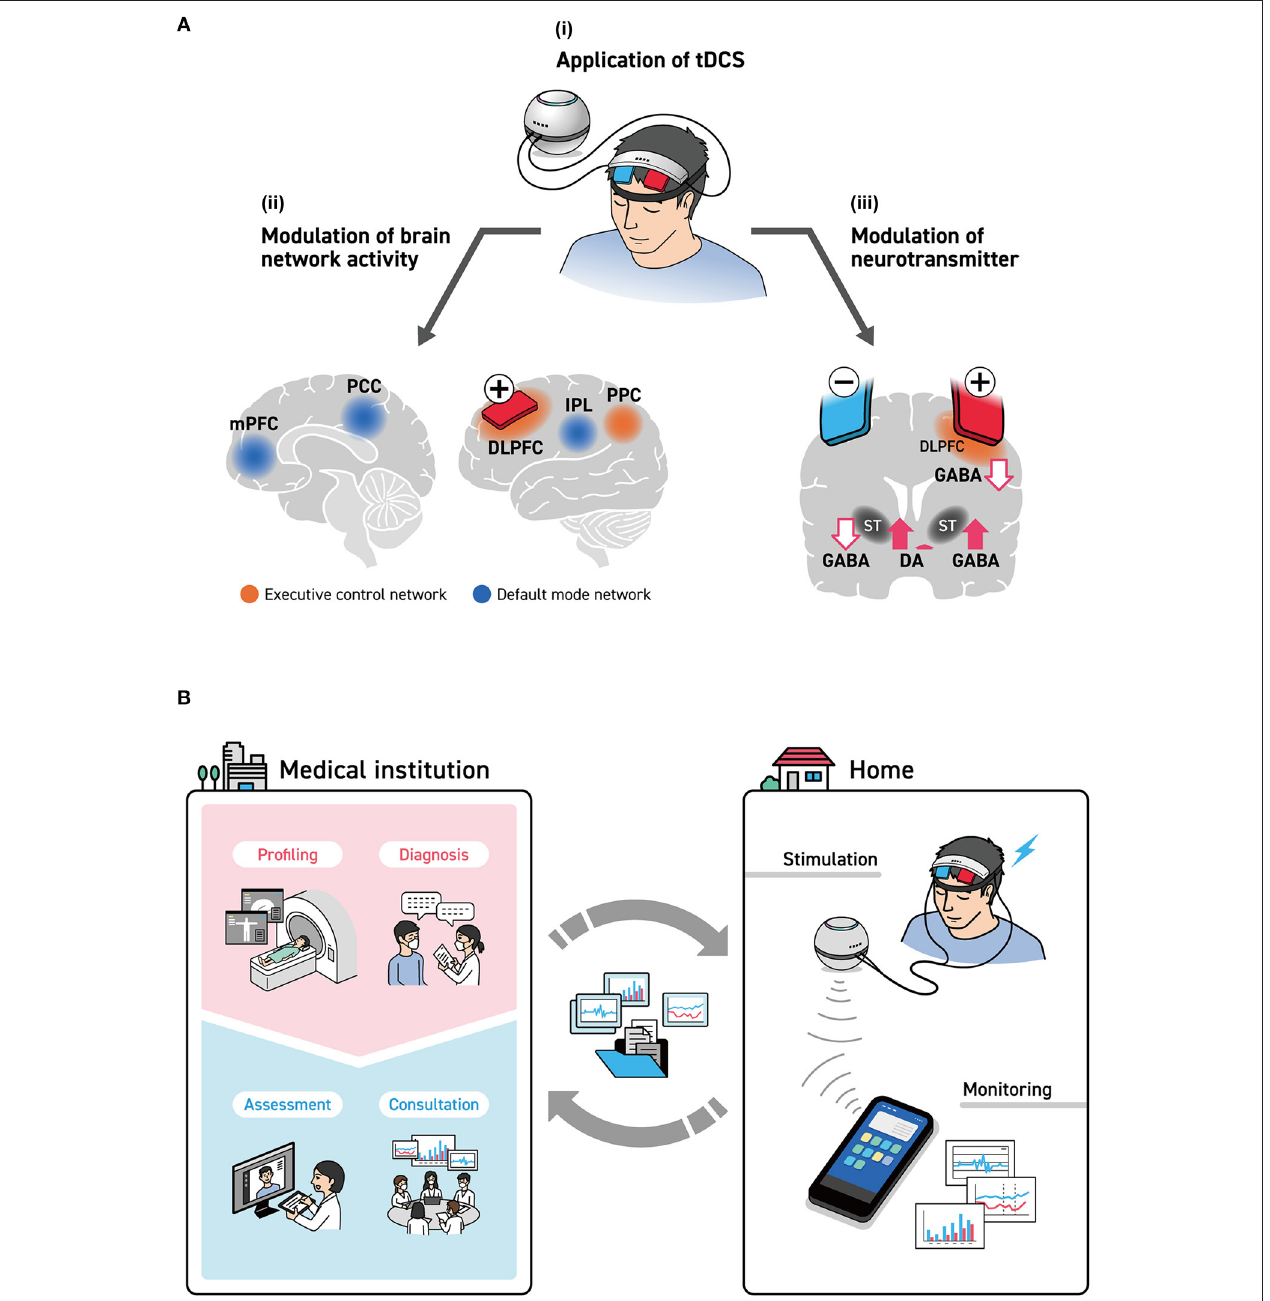
FIGURE 1 | (A) brain stimulation by tDCS. (i) With the intent of stimulating the left DLPFC to improve cognitive function and mood, an anode was installed on F3 as defined under the International Standard ten-twenty electrode system. Many studies, however, have installed cathodes on either the F4 of the right hemisphere or the forehead. (ii) The spread of the effects of tDCS to the cerebral cortex, as estimated by the EEG/MEG studies are seen with the executive control network (DLPFC, SFC, and PPC) and the default mode network (mPFC, PCC, and IPL). (iii) The influence of tDCS stimulation of the left DLPFC on neurotransmitters. This brings about the release of dopamine in the right striatum and a reduction in GABA concentration, while it brings about an increase in GABA concentration in the left striatum. DLPFC, dorsolateral prefrontal cortex; IPL, inferior parietal lobule; mPFC, medial prefrontal cortex; PCC, posterior cingulate cortex; PPC, posterior parietal cortex; SFC, superior frontal cortex; ST, striatum. (B) tDCS-based telemedicine system, including medical institutions. In hospitals, meticulous examinations and brain measurements are done by physicians and specialists, who formulate stimulation parameters. Here, the structural data of the head were obtained by CT and MRI, and more detailed data on brain functions were obtained by fMRI, MEG, and PET to determine the optimal positions on the scalp for providing tDCS as well as parameters that are suited to individual patients. Brain condition before and after stimulation was measured by simple EEG, and the effects of tDCS were monitored as needed. These data are delivered to medical specialists via smart devices and are used to confirm the effects of treatment and formulate the next treatment plan.